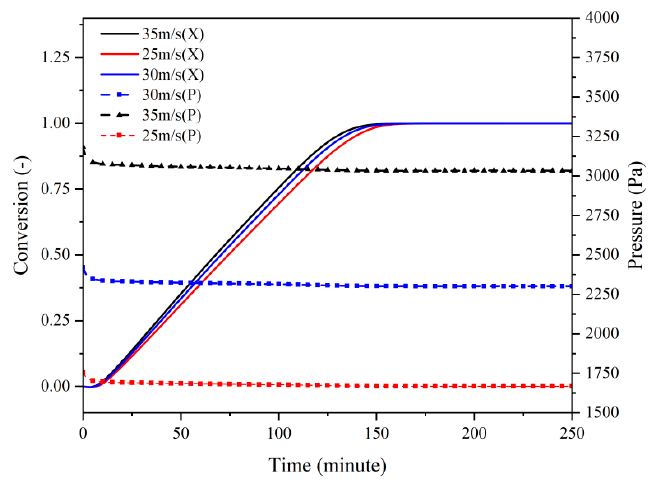
Figure 9. Conversion (X) curves and pressure (P) at the inlet of the flow channel of the PPFHS reactor under 25m/s, 30 m/s and 35 m/s. (dehydration, ε = 0.5).